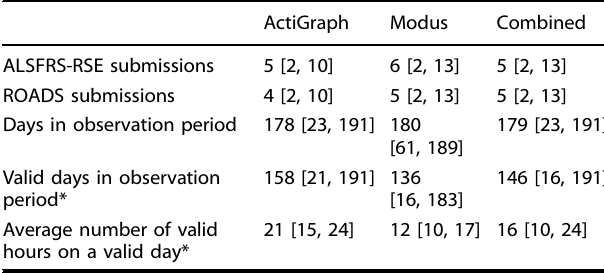
Table 2. Phone-survey and wearable device compliance (Aggregate